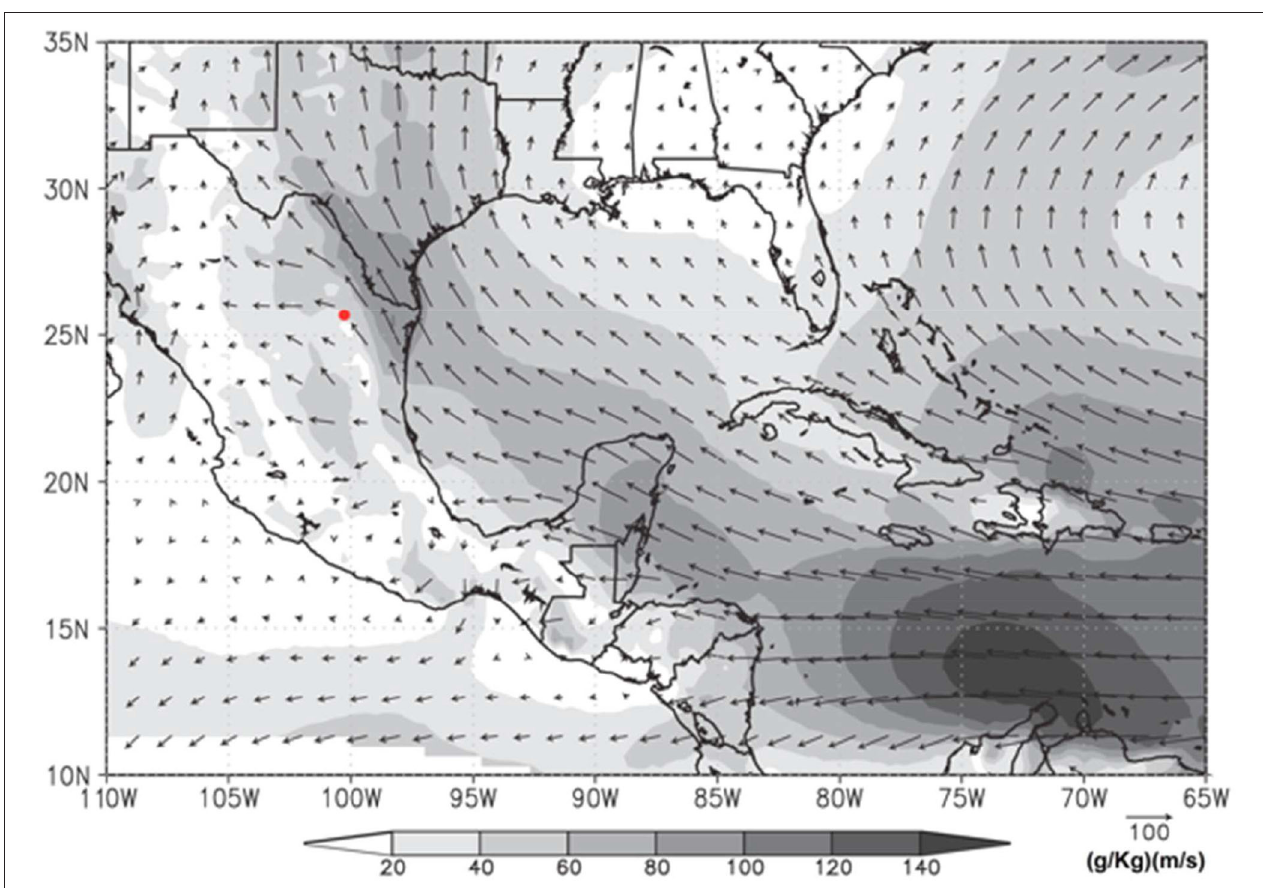
FIGURE 4 | Climatology of the mean moisture flow at 925 hPa for the June-September period. Vector corresponds to moisture flux direction and shades of gray to moisture flux magnitude (g/kg)